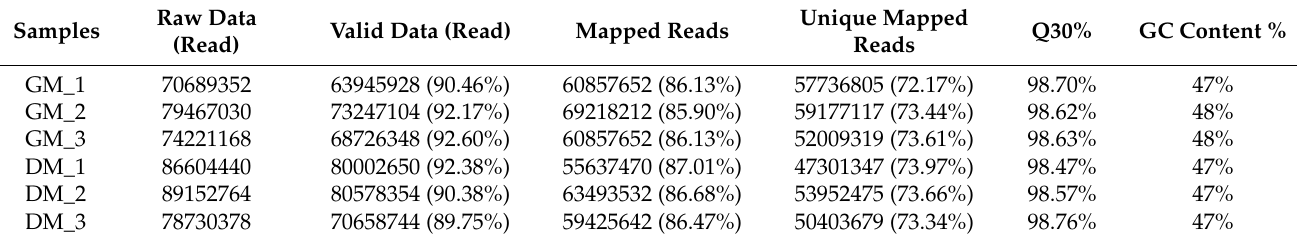
Table 1. A comparison of sequencing data among